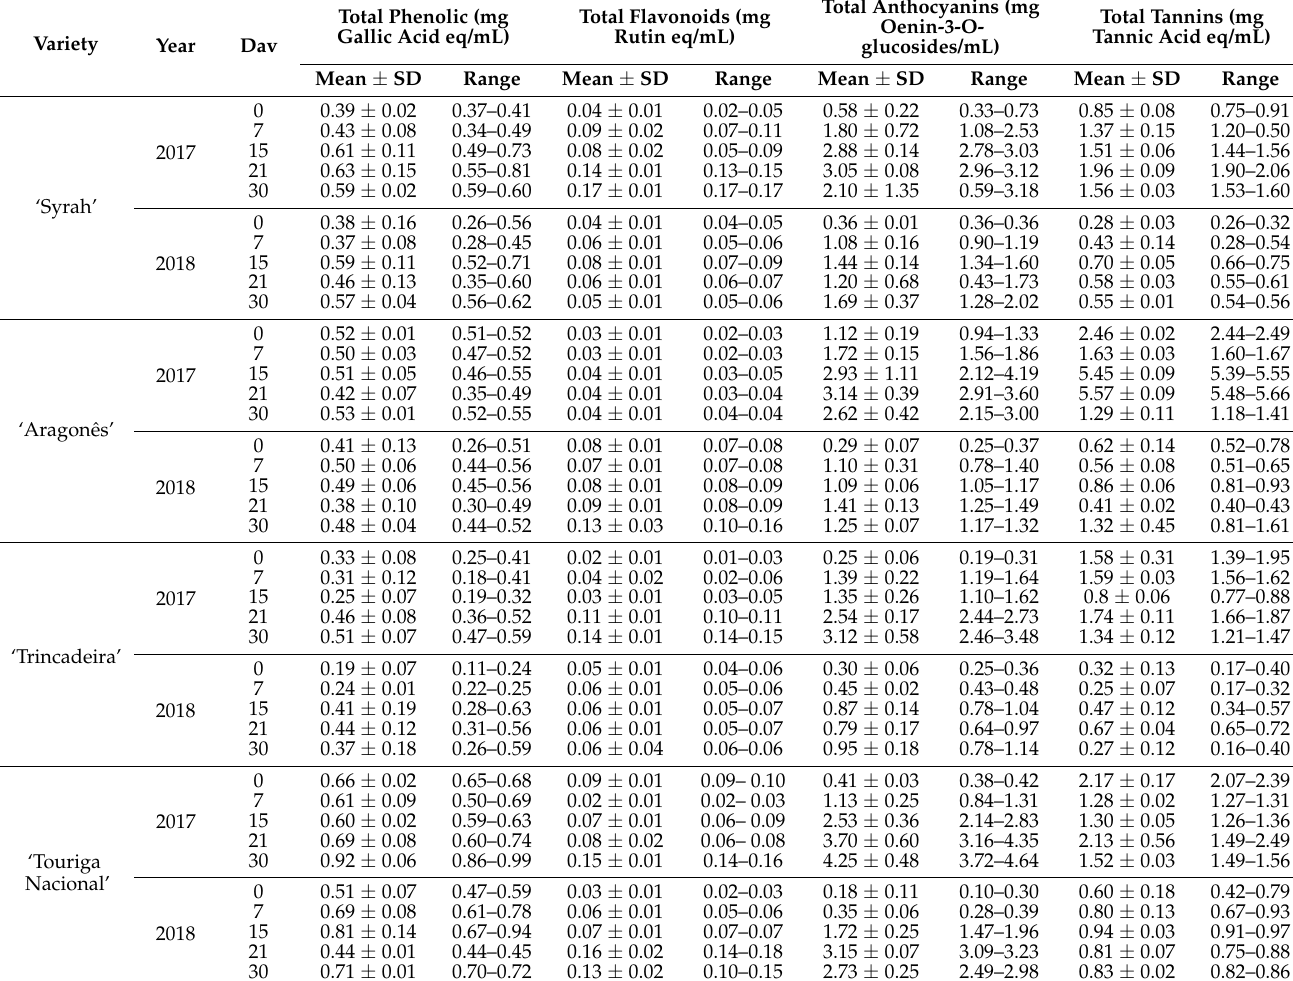
Table 2. Total of phenolic content (mg Gallic acid equivalent/mL of extract), flavonoids (mg Rutin eq/mL grape skin extract), anthocyanins (mg Oenin-3-O-glucosides/mL of grape skin extract), and tannins (mg Tannic acid eq/mL grape skin extract) extracted from grape skin from samples collected in 2017 and 2018 in the days after v é raison